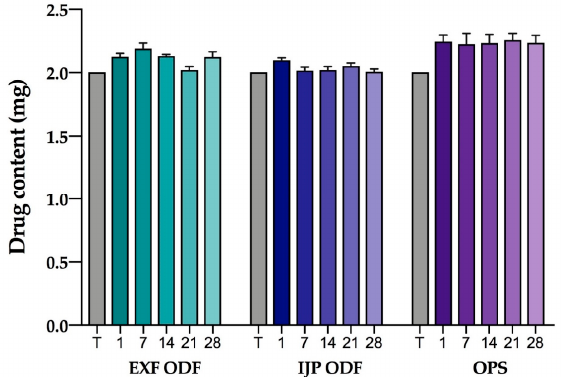
Figure 7. Stability of the manufactured dosage forms with a target dose of 2 mg at time points 1, 7, 14, 21, and 28 days. The gray columns represent the target dose of 2 mg. Data shown as average ± SD, n = 10.